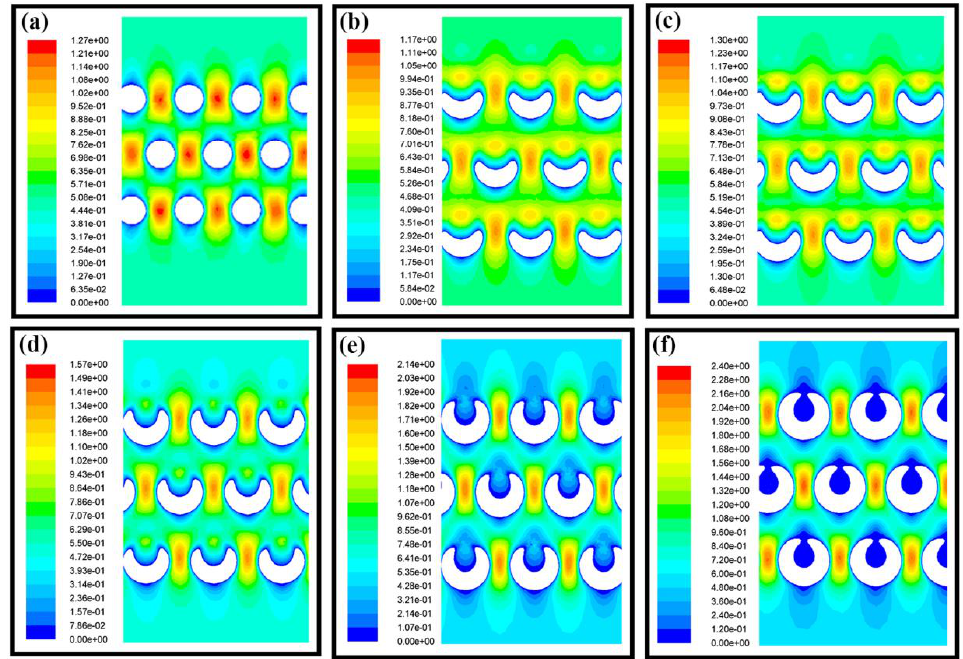
Figure 4. The velocity distribution of airflow in different fiber membranes. ( a ) cylindrical fiber with a diameter of 2.0 µm; ( b – f ) spiral fibers with a diameter of 2.0 µm and the pitch was 4.0 µm, 3.5 µm, 3.0 µm, 2.5 µm and 2.1 µm, respectively. diameter of 2.0 µ m; ( b – f ) spiral fibers with a diameter of 2.0 µ m and the pitch was 4.0 µ m, 3.5 µ m, 3.0 µ m, 2.5 µ m and 2.1 µ m,